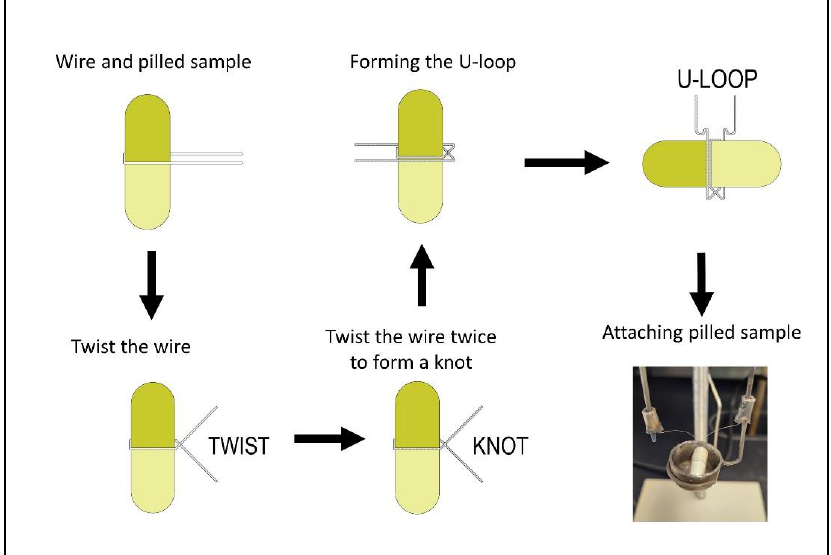
Figure 3. Preparing and attaching pilled sample into the combustion